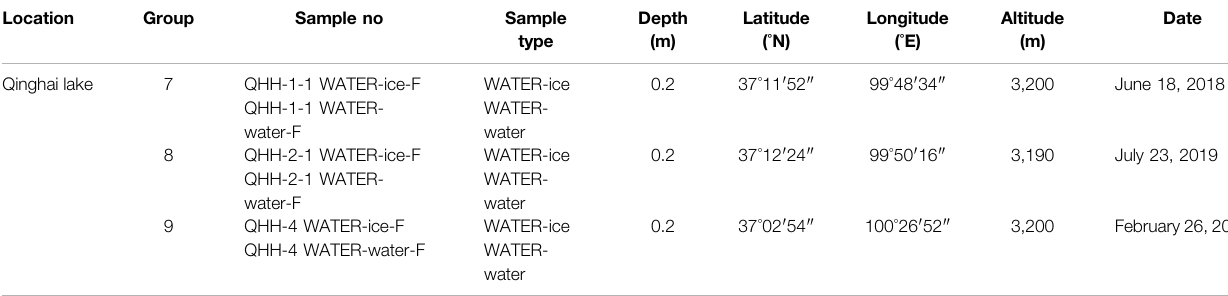
TABLE 2 | Sampling site information for water samples from Qinghai Lake.